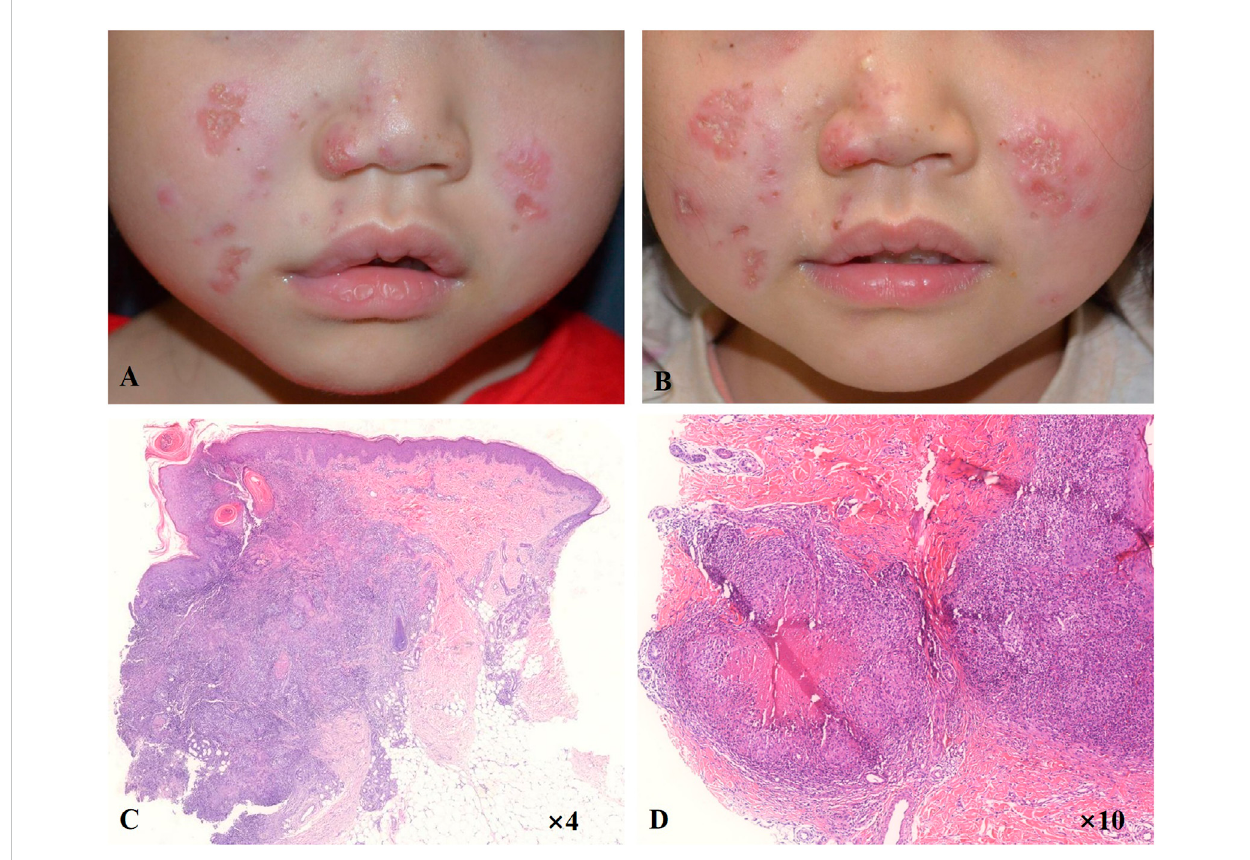
FIGURE 1 RuV infection-induced cutaneous granulomatous dermatitis. Erythematous plaques on cheeks at visit (A) and after 10-month follow-up (B) . (C) Dense lymphohistiocytic in fi ltrate in the dermis forming a nodule. (D) Necrotizing granulomas in the deep